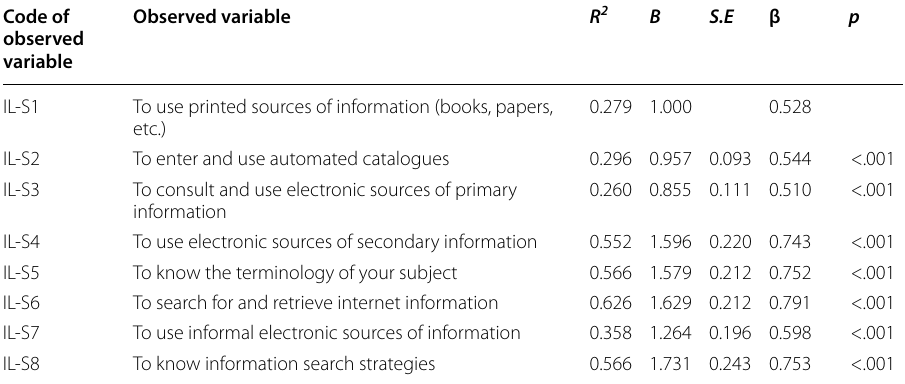
Table 8 Standardized and unstandardized coefficients of latent variable pre-service teachers’ perceived information search literacy